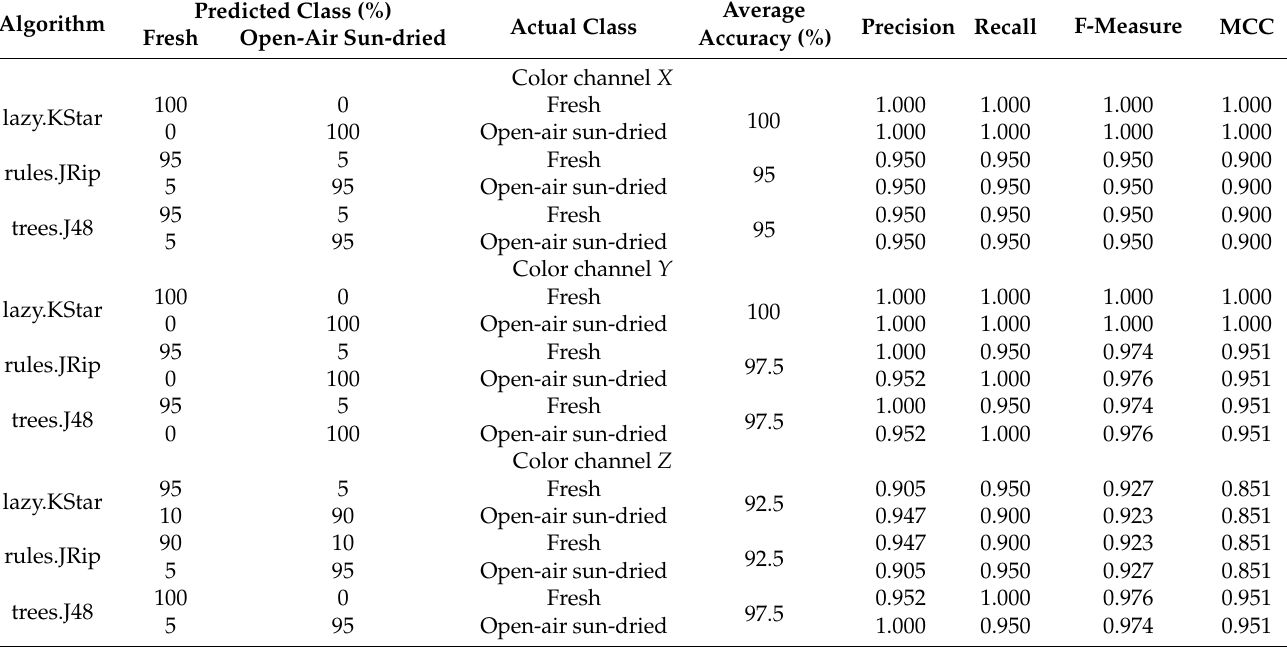
Table 6. The classification performance metrics for fresh vs. open-air sun-dried mint leaves imaged on the ventral side based on models including selected textures from color channels X , Y , and Z from color space